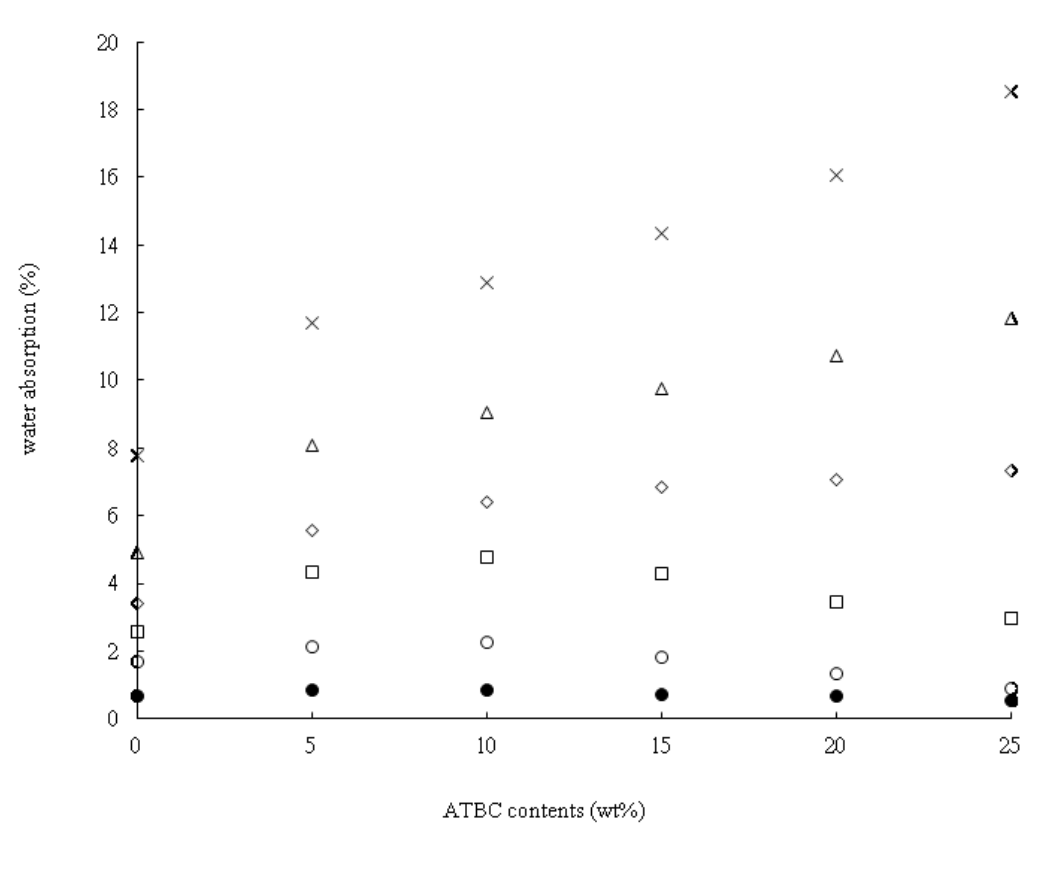
tapioca MDI ; ( ◇ ) PLA 80 20 0.5 tapioca MDI 50 50 0.5